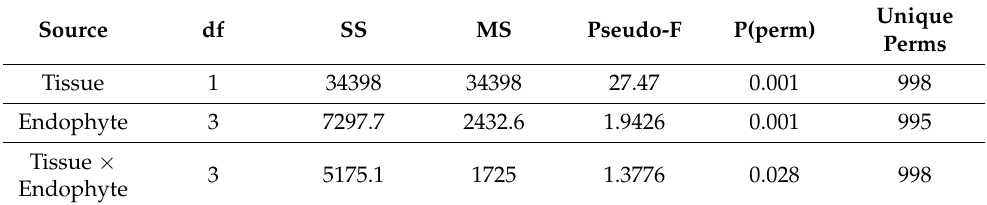
Table 2. PERMANOVA results for Epichloë -depleted fungal communities in meadow fescue.